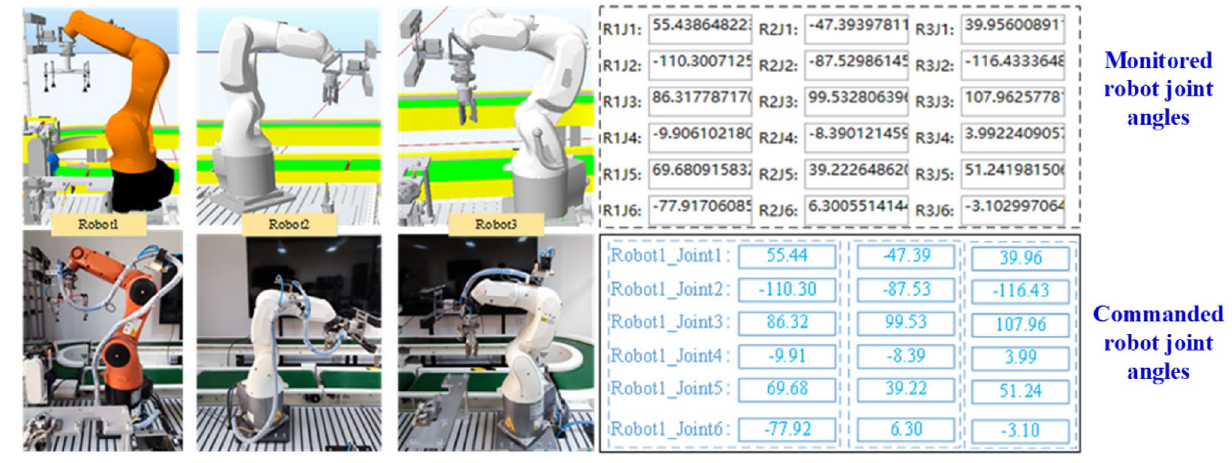
Figure 7. Interactive movement control between VE and